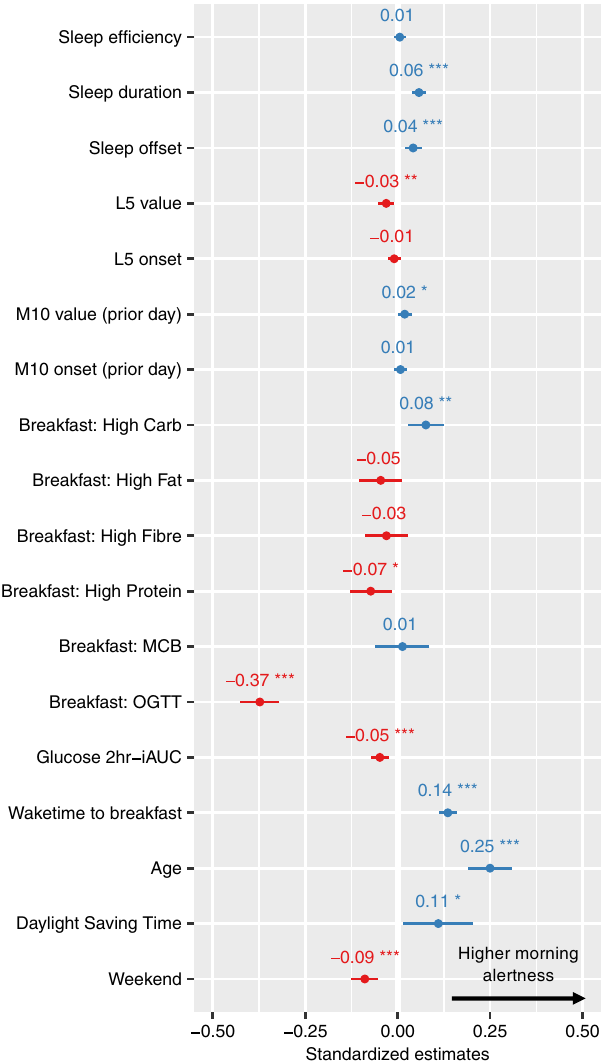
Fig.3|Predictorsofday-to-day fl uctuationsinmorningalertness. Standardised regression coef fi cients and con fi dence intervals from a linear mixed effect model. Sex, BMI, zygosity and sunrise time were also included in the model but are not reported here for conciseness since none of them was a signi fi cant predictor of morning alertness.Unstandardised regressioncoef fi cientsandrawp-valuescanbe found in Supplementary Table 1. Sleep predictors were normalised using person- meancentering.Thedependentvariableofthemodelismorningalertness,whichis calculated by averaging the alertness ratings that were made within the fi rst three hours after breakfast start (n=6,744 observations). Family ID and participant ID werede fi nedasnestedrandomeffectsofthelinearmixedmodel.Predictorswitha positive coef fi cient (i.e predicting higher morning alertness) are shown in blue, while those with a negative coef fi cient (lower morning alertness) are shown in red. Error bars represent 95% con fi dence intervals. Stars indicate signi fi cance. P-values arebasedontwo-tailedWaldtests(degreesoffreedom=6717)andarenotadjusted formultiplecomparisons.*p<0.05,**p<0.01,***p<0.001.L5=leastactive5hours of the day, M10=most active 10hours of the day, MCB metabolic challenge breakfast, OGTT Oral Glucose Tolerance Test, iAUC incremental area under the curve. Source data are provided as a Source Data fi